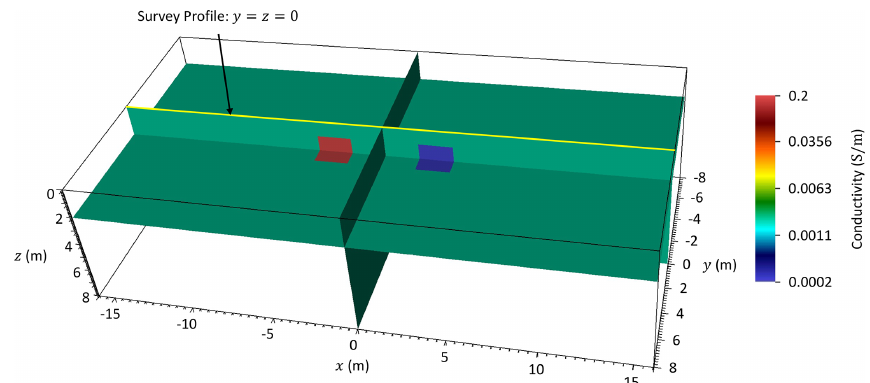
Figure 5. Three-dimensional earth resistivity model composed of two anomalous blocks embedded in a homogeneous background. ERT pro- filing data are simulated along a survey profile at y = z = 0m from x = − 16m to x = 16m using the Wenner configuration with increasing electrode spacing a from 1 to 6m.